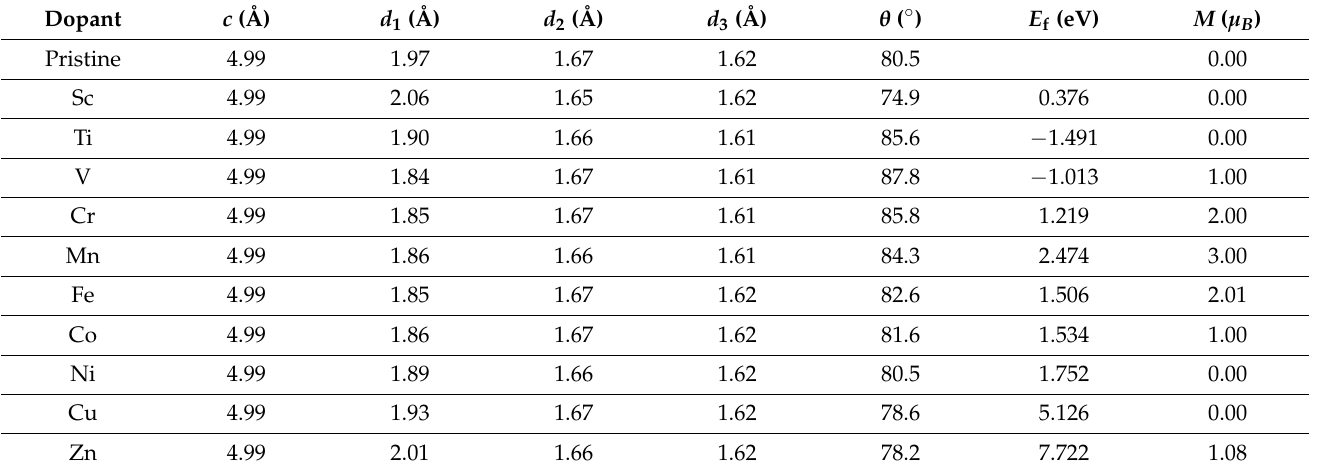
Table 2. The typical structural parameters c , d 1 , d 2 , d 3 , and θ associated with site 1, the formation energy E f , and the magnetic moment M of aMoSiNNRs undoped and doped by 3 d TM elements (Sc-Zn) at site